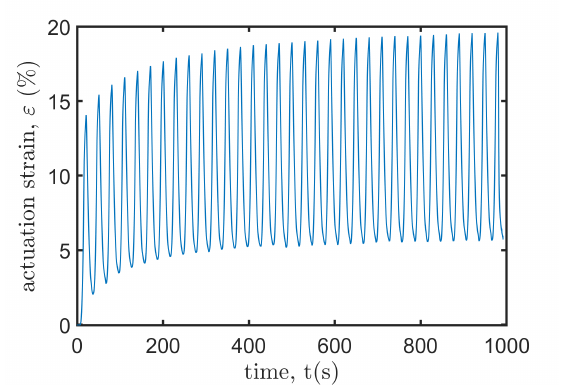
Figure 10. The actuation strain ε x varies with the cyclic trapezoid input